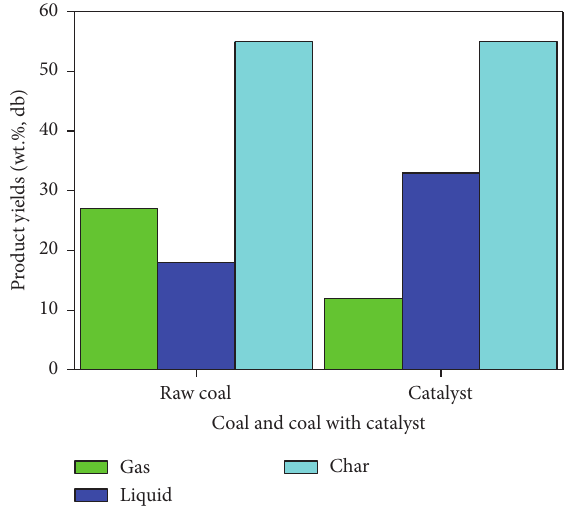
Figure 3: Pyrolysis product yields based on temperatures without catalyst.